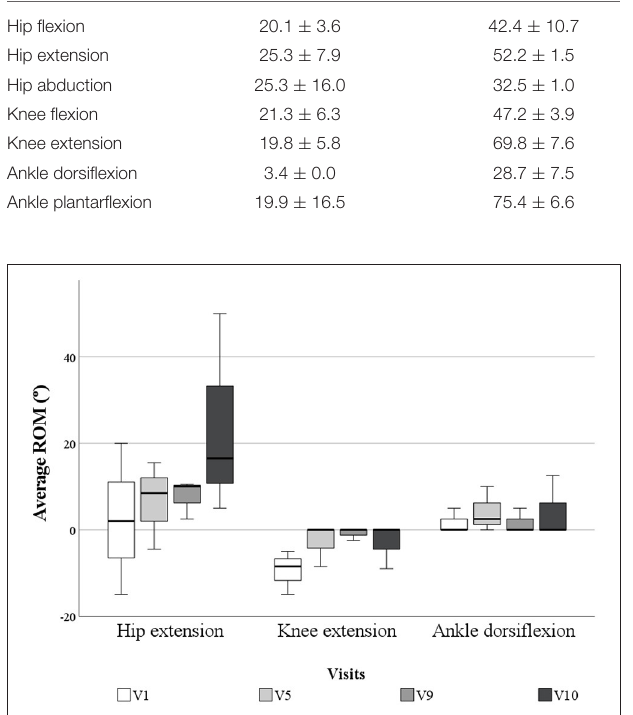
FIGURE 3 | Average ROM of the hip and knee extension and ankle dorsiflexion in degrees for all the patients during the control visits.